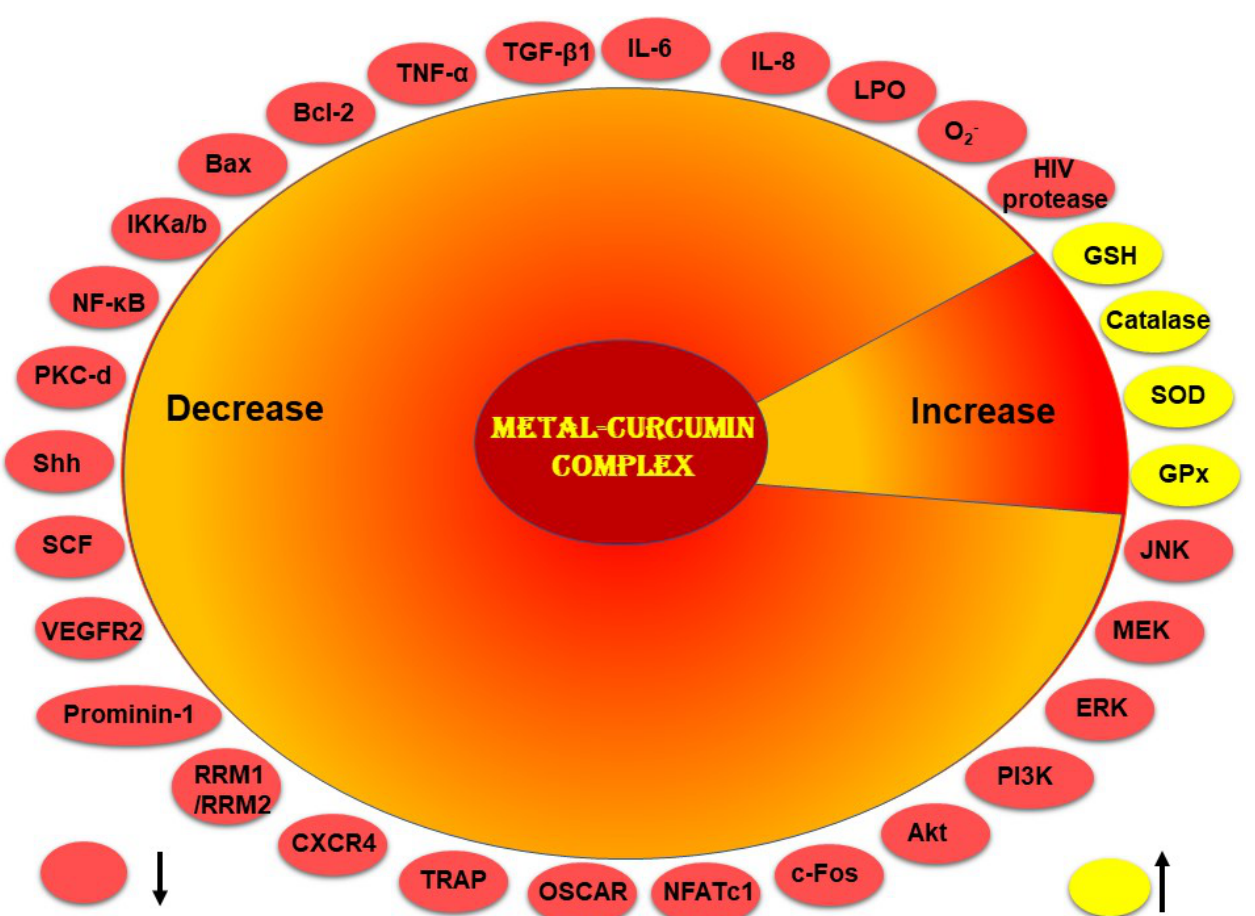
Figure 3. Curcumin–metal complex modulates biomarkers that are involved in health and